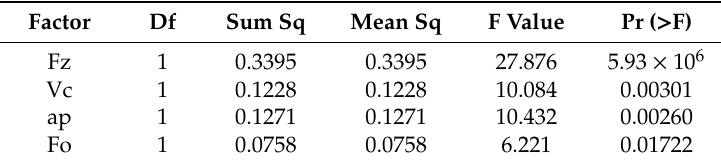
Table 10. Analysis of variance (ANOVA).